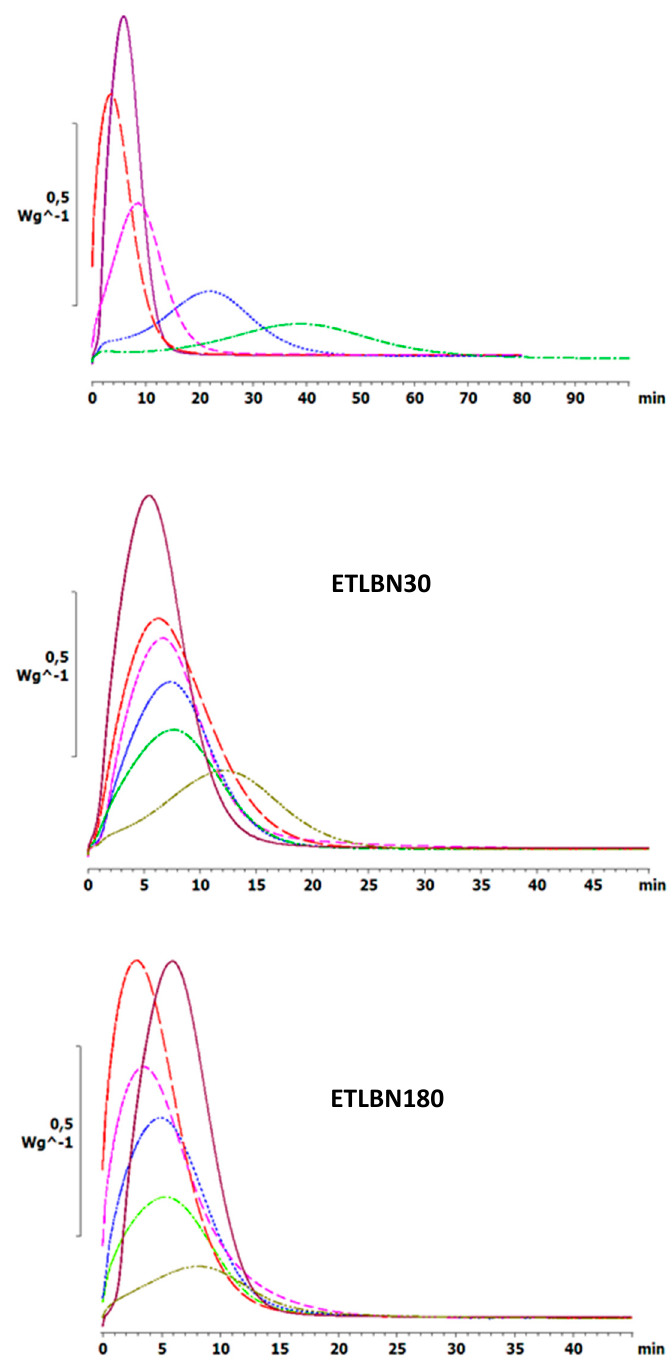
Figure 4. Isothermal DSC scans at 70 ◦ C for ETLBN2- y , ETLBN30- y and ETLBN180- y , in which y refers to the di ff erent BN contents given in Table 1: purple, full line, y = 0; long dash, red, y = 10; short dash, pink, y = 30; dash-dot, blue, y = 50; dotted, light green, y = 60; dash-double dot, dark green, y = 70.